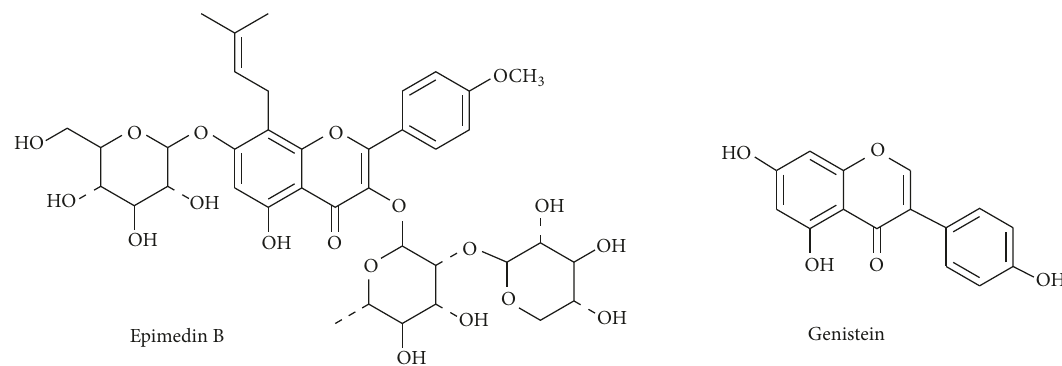
Figure 1: Chemical structure of epimedin B and genistein (internal